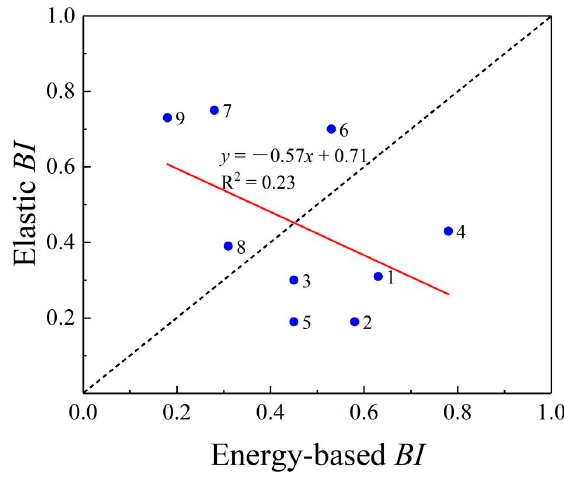
Figure 5. Comparison between the energy-based BI and elastic BI .